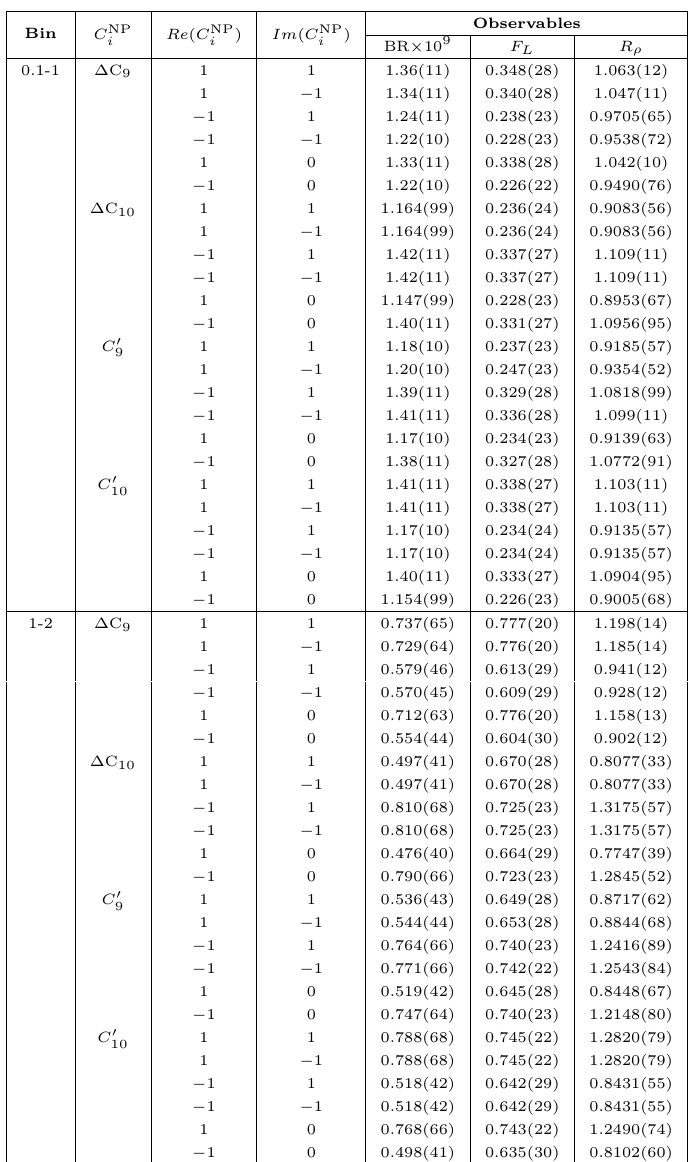
Table 40 . The dependence of the Branching Ratio and the observables F L and R ρ corresponding to ¯ B ( B ) → ρ 0 ll on the real and imaginary parts of the NP WC’s ∆ C 9 , 10 and C 0 and 1 − 2 GeV 2 for a few benchmark values of the real and imaginary parts of the corresponding